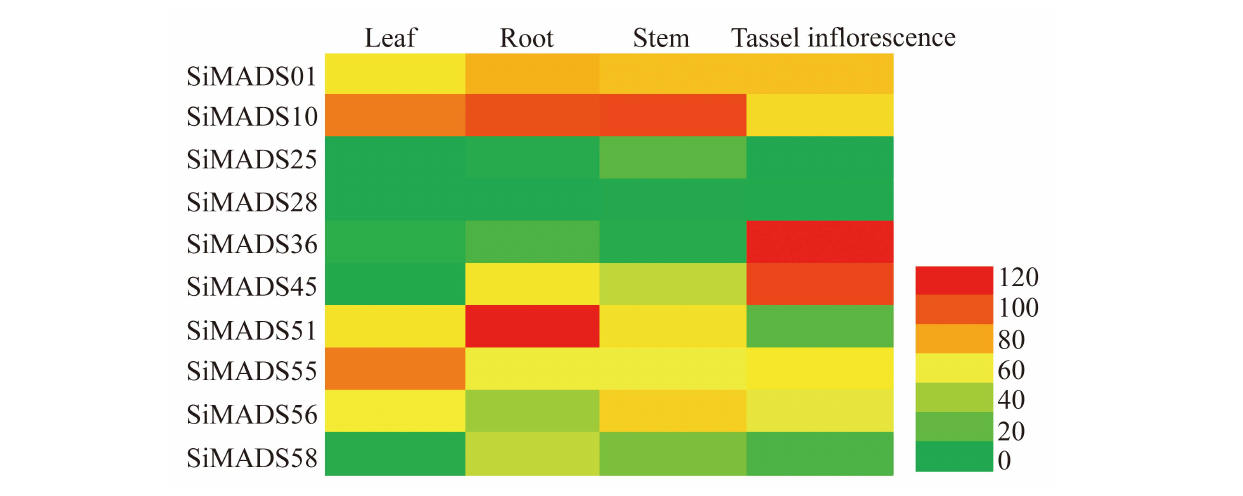
FIGURE 5 | The transcript accumulation of ten SiMADS-box genes in various foxtail millet tissues (root, leaf, stem, and tassel inflorescence). The transcriptome data of foxtail millet for different tissues were obtained from Expression Atlas. A heatmap was generated using EvolView. Transcript levels are indicated by different colors.